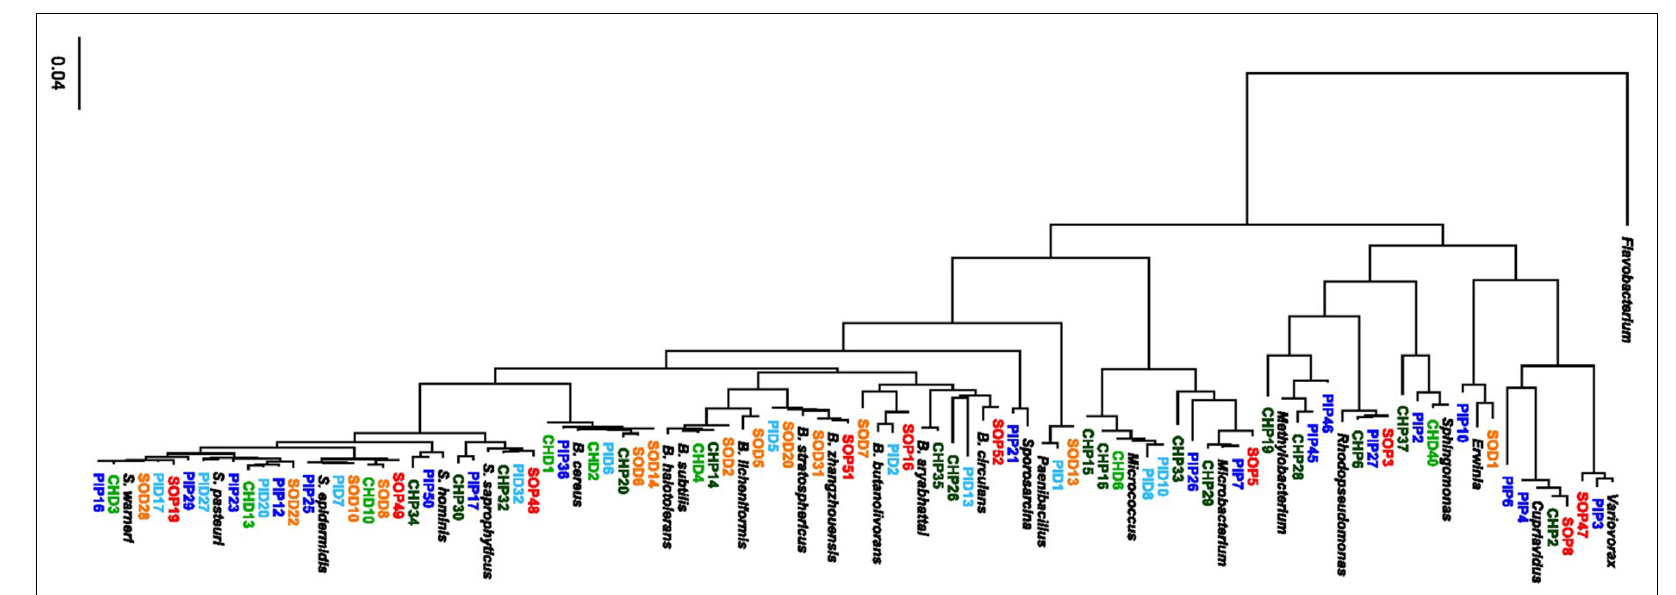
FIGURE 1 | Phylogenetic tree of 78 non-redundant isolates from the microbiome of grapevine leaves. The tree was constructed using the Genious software (see Materials and Methods for details). Isolates from Pinot Noir are shown in blue, with epiphytes (PIP) in dark blue and endophytes (PID) in light blue. Isolates from Solaris are shown in red/orange, with epiphytes (SOP) in red and endophytes (SOD) in orange. Isolates from Chasselas are shown in green, with epiphytes (CHP) in dark green and endophytes (CHD) in light green. A Flavobacterium sequence (MK246909.1) was used as an outgroup and reference sequences from different genera and different species within the Bacillus (B.) and Staphylococcus (S.) genera corresponding to the following accession numbers were included: Variovorax (NR_113736.1), Cupriavidus (NR_074704.1), Erwinia (NR_148650.1), Sphingomonas (NR_104893.1), Rhodopseudomonas (NR_114302.1), Methylobacterium (NR_115219.1), Microbacterium (NR_042480.1), Micrococcus (NR_134088.1), Paenibacillus (NR_044524.1), Sporosarcina (NR_025049.1), B. circulans (FJ581445.1), B. aryabhattai (NR_115953.1), B. butanolivorans (MN235850.1), B. zhangzhouensis (NR_148786.1), B.